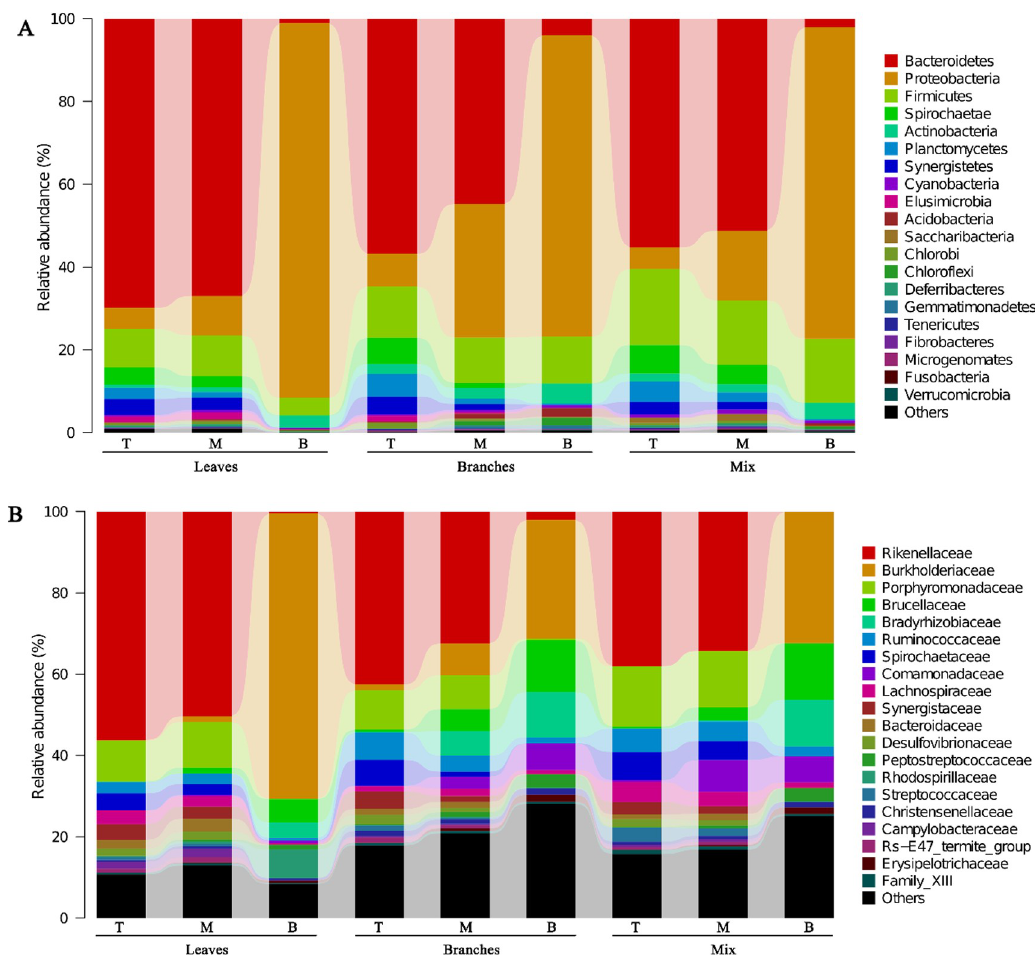
Fig 4. The bacterial community structure at different decomposition stages of fungus-combs. (A) The bacterial community structure at the phyla level. (B) The community composition at the family level.